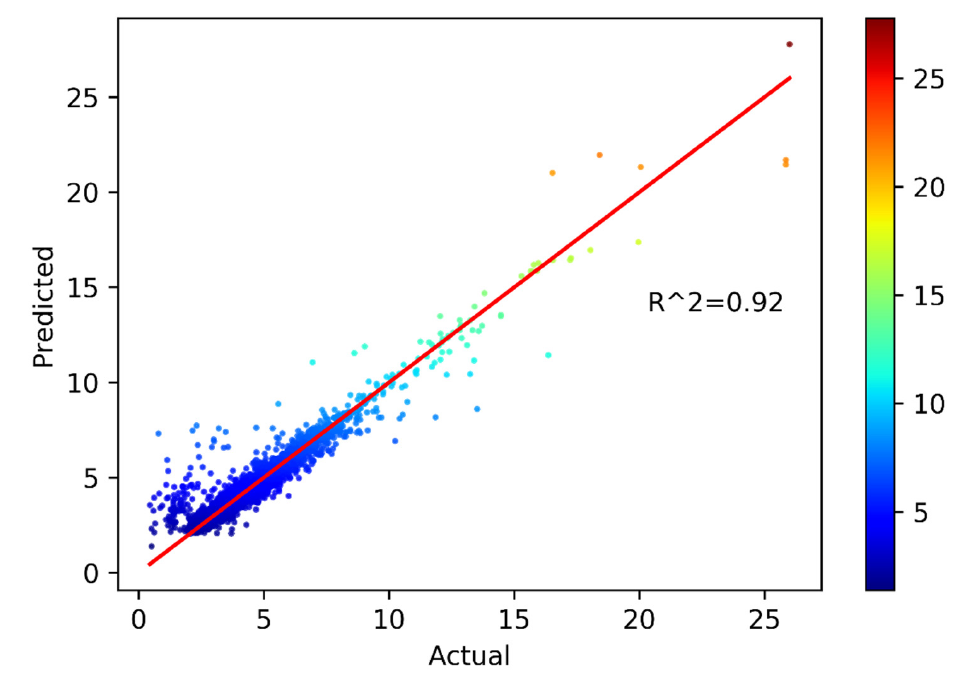
Figure 7. Actual and predicted property prices based on test set (RF).